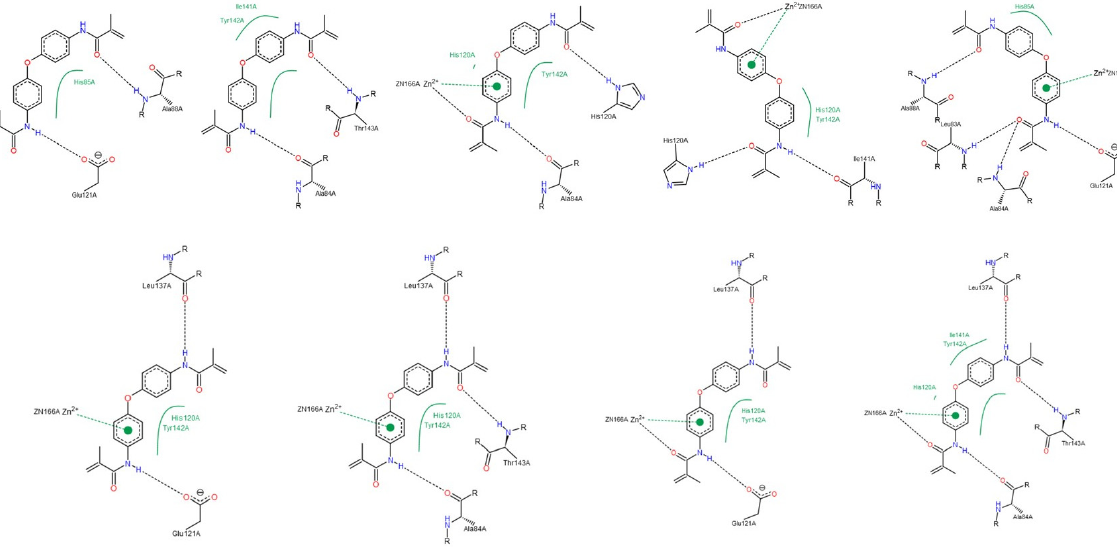
Figure A17. Interactions between compound C and MMP-2, by PoseView calculations.